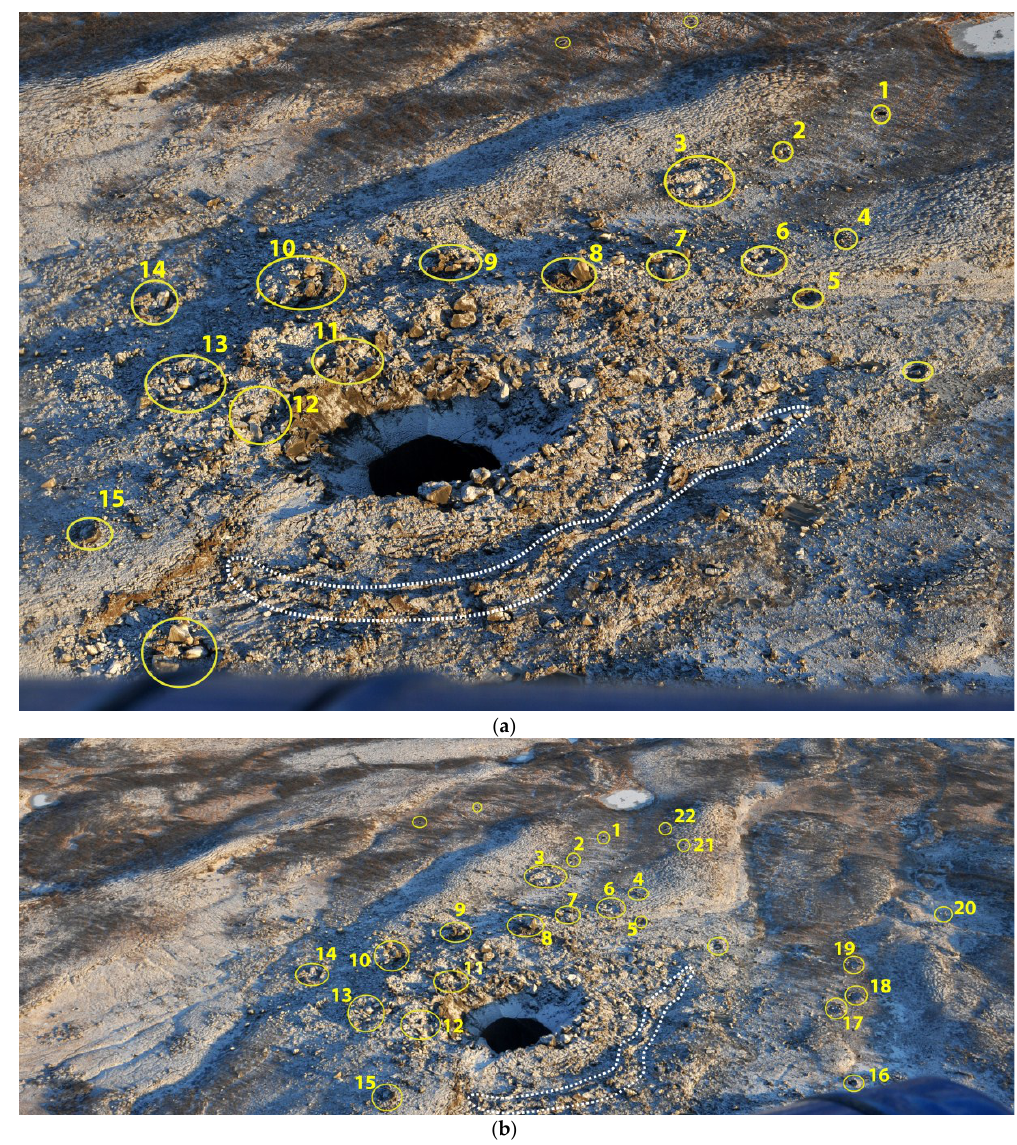
Figure 8. Photographs ( a , b ) from the helicopter on 14 November 2012, characterizing the location of blocks of ice and frozen deposits ejected from GEC-2. Numbers indicate impact hollows and blocks of icy deposits reliably correlated with these blocks on imagery.